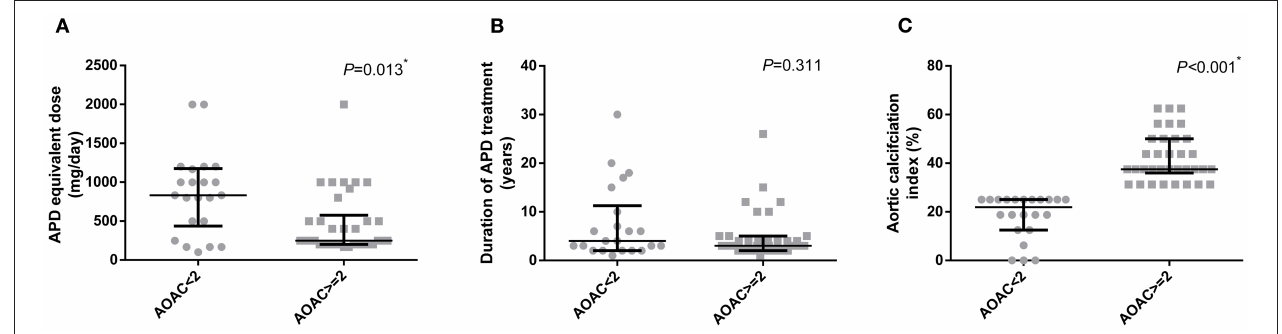
FIGURE 1 | Comparison of APD medication profiles in patients according to their AoAC index. (A) APD equivalent dose, (B) duration of APD treatment, (C) Aortic calcification index. * p < 0.05. APD, antipsychotic drug.